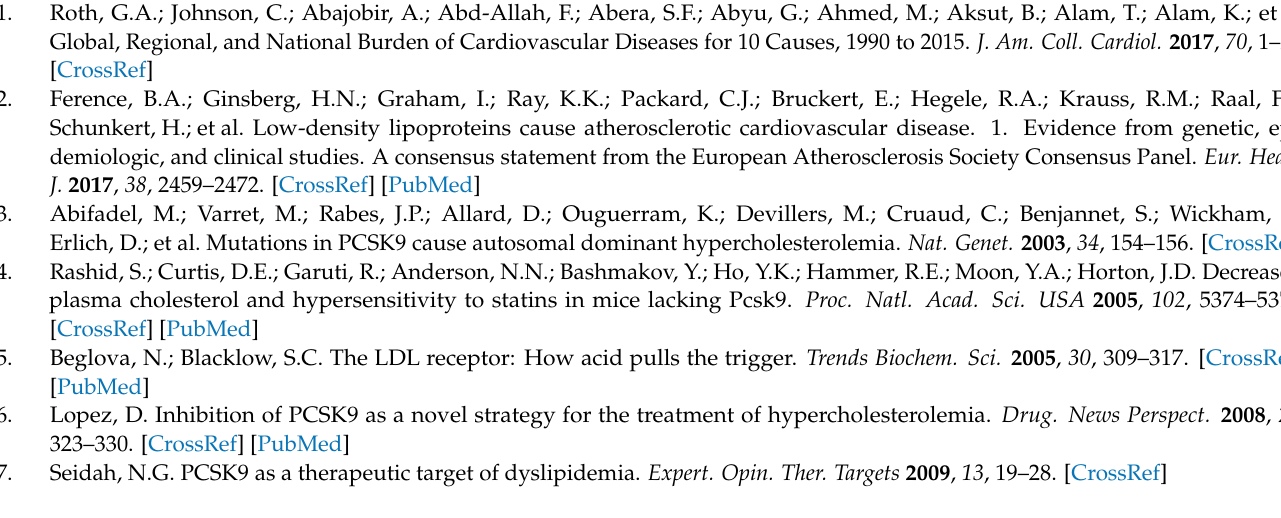
CBE, Figure S2: Standard curves used for quantification of sinensetin, acacetin, and